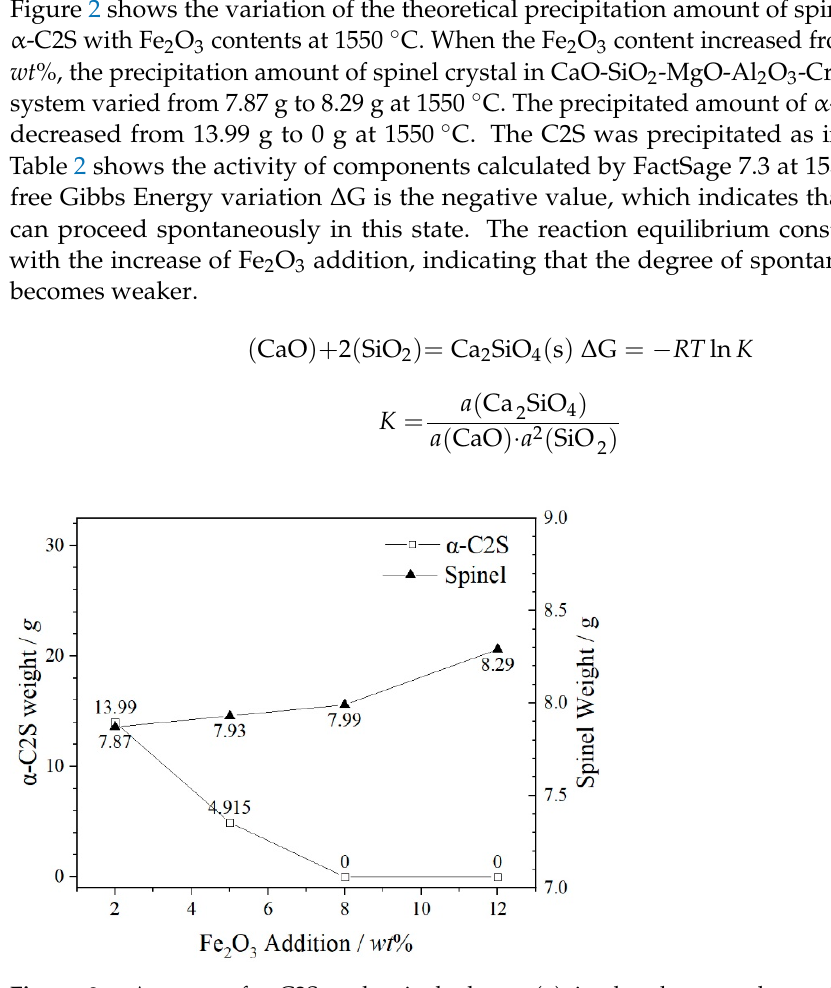
Figure 2. Amount of a-C2S and spinel phases (g) in the slag samples at 1550 °C versus Fe 2 O 3 addition (%) .